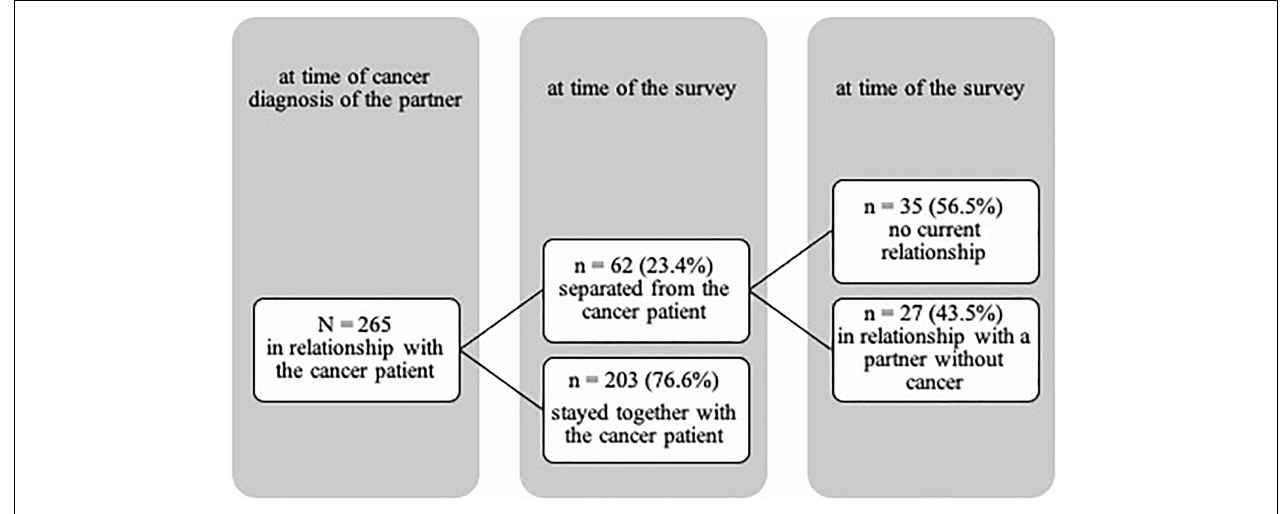
FIGURE 1 | Changes in relationship status of the sample between the time of the cancer diagnosis of the partner and the time of the